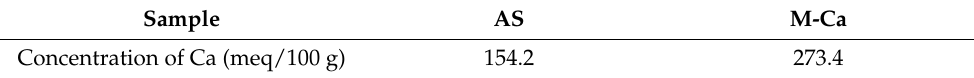
Table 4. Ca content extracted with 1 M NH 4 Cl.